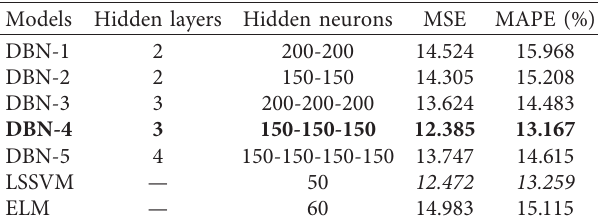
Table 6: Comparison between DBN and other models.